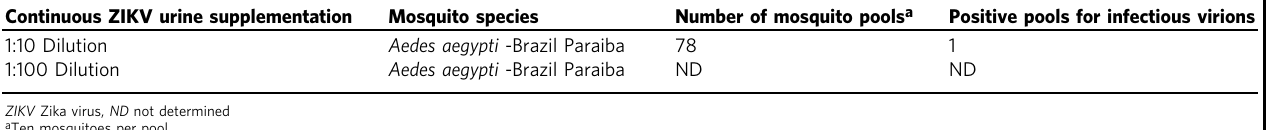
Table 2 Measurement of infectious ZIKV particles in mosquitoes Continuous ZIKV urine supplementation Mosquito species